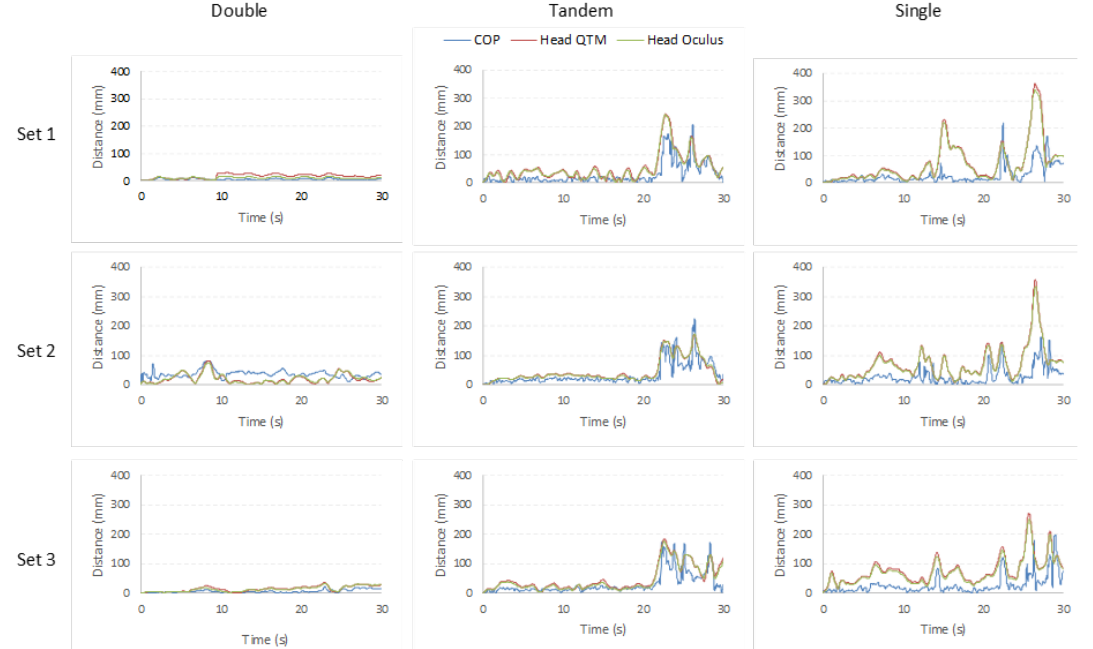
Figure 3. Graphs showing the distance covered by each of the three signals calculated in all three data sets for the COP (blue), Head Sway Qualisys (red) and Head Sway Oculus (green) measures. Notice how the correspondence is closest for all 3 signals in the Tandem stance data. This is also reflected in the ICC values presented in Table 2. Table 2. The ICC values for head sway and CoP data in the ML, AP axes of motion for each of the three stances (Double, Tandem, Single). The ICC values for COP excursion and Head Sway (distance column) combine movement in both